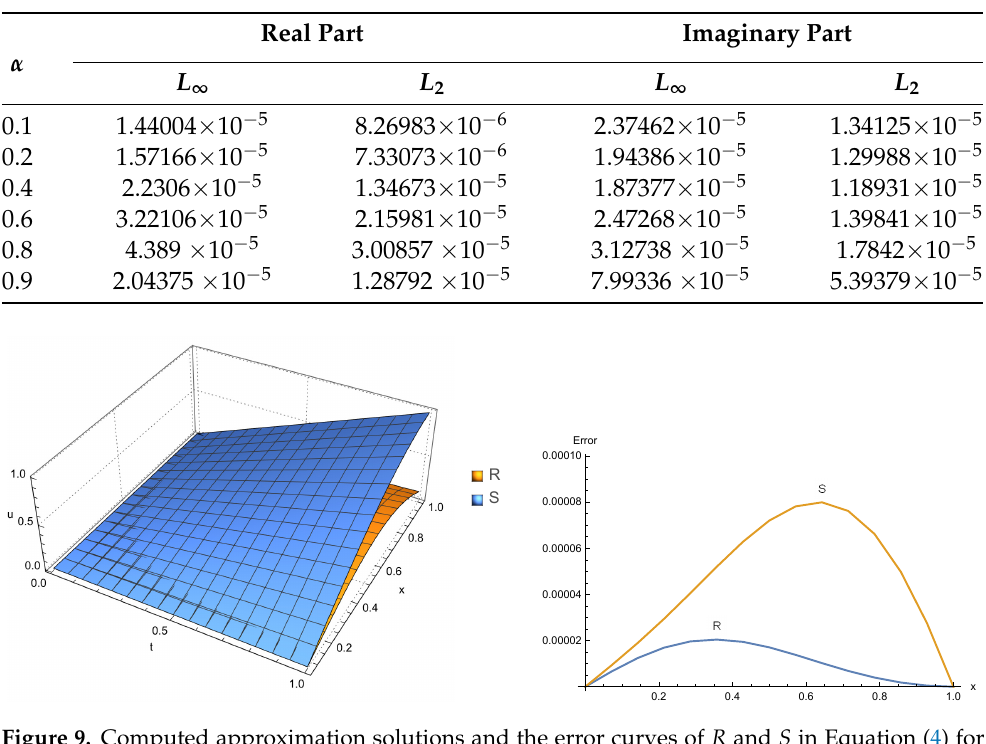
Table 11. Error norms of real and imaginary parts of Equation (4) for different α at N = 15, τ = 1/512, and t = 1.